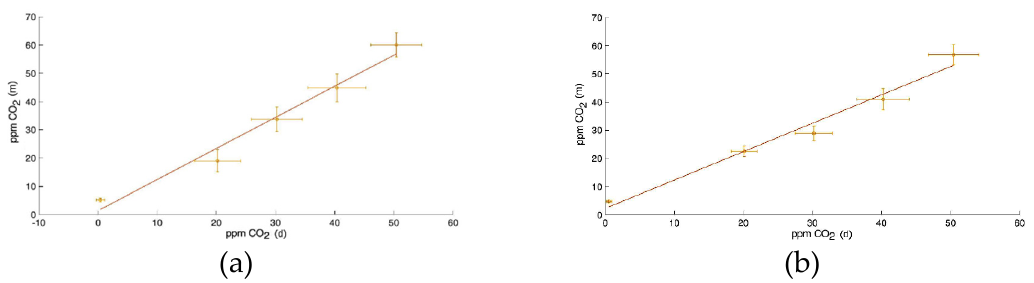
Figure 4. The best-line fits of the two tests: the first, ( a ) reports the increasing concentration test, while the second, ( b ), the decreasing concentration test. In both figures, the x axis (ppm CO 2 (d)) reports the CO 2 concentrations driven into the flux chamber unit, while the y axis (ppm CO 2 (m)) reports the CO 2 concentrations measured.